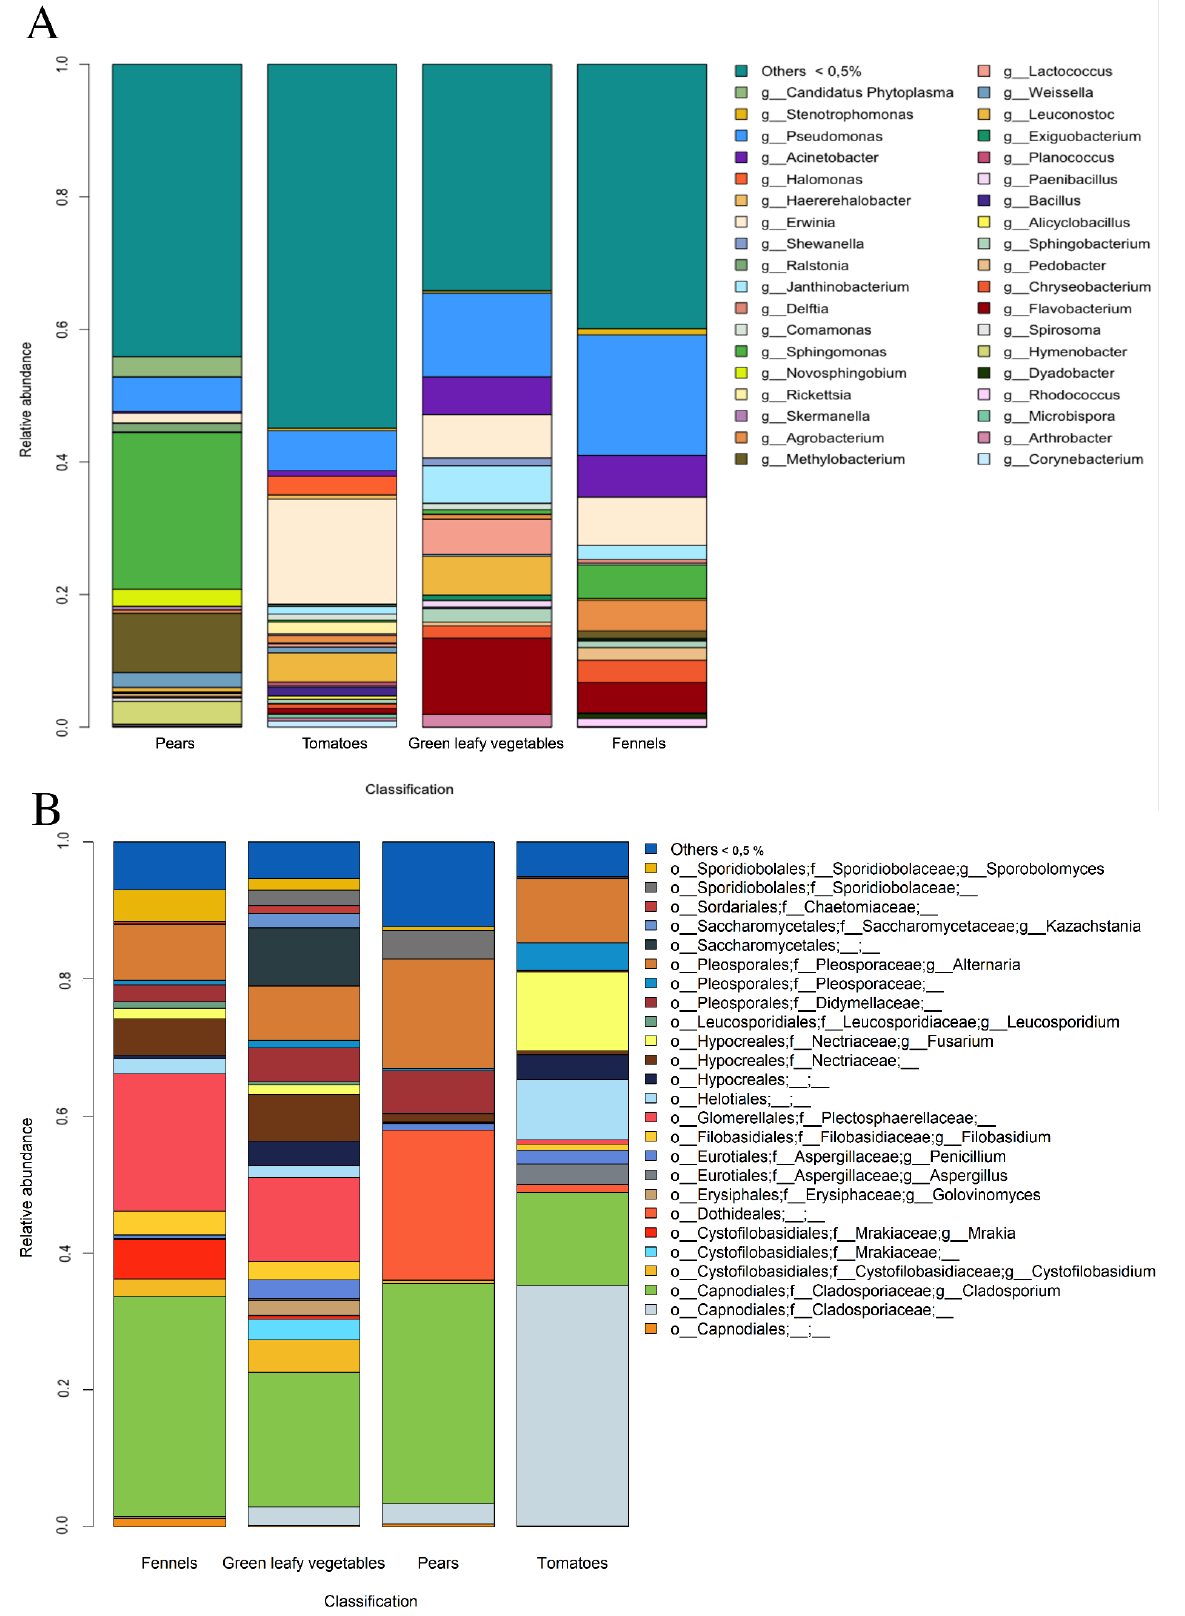
Figure 2. Barplots showing the mean relative abundance of ( A ) bacterial and ( B ) fungal genera within each type of F&V. Only taxa with a mean relative abundance > 0.5% are